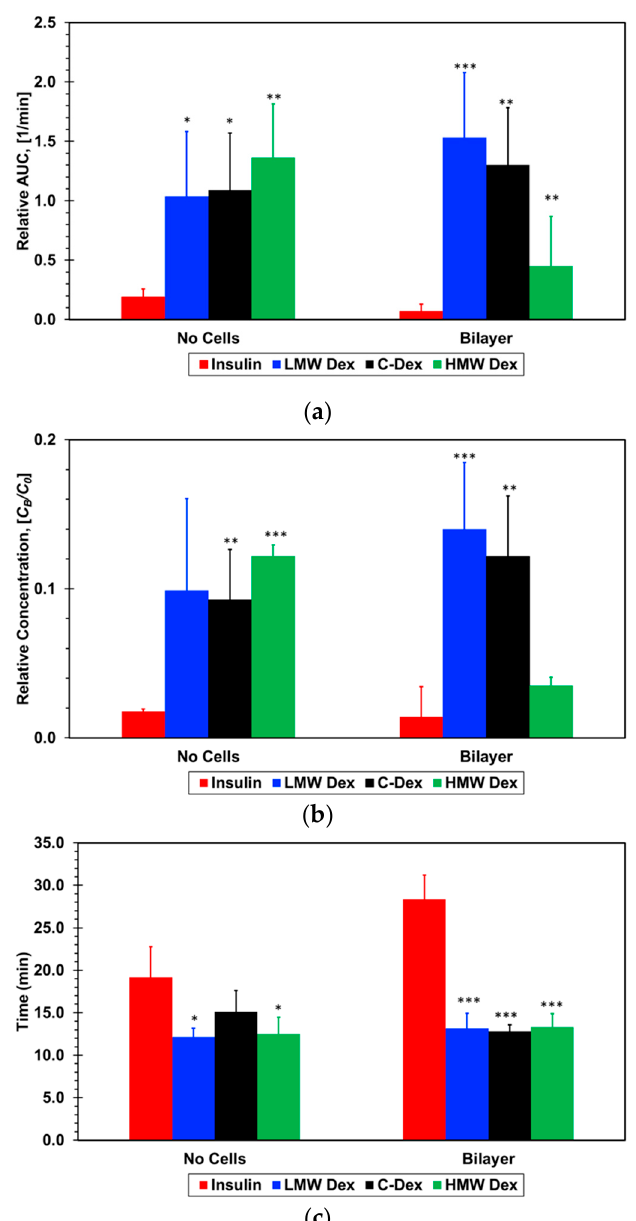
Figure 7. Pharmacokinetic parameters extracted from the concentration–time plots: ( a ) Relative area under the curve, AUC, ( b ) maximum concentration, C max , and ( c ) time to reach maximum concentration, T max , for the four molecules tested. * p < 0.05, ** p < 0.01, *** p < 0.001 compared with insulin.